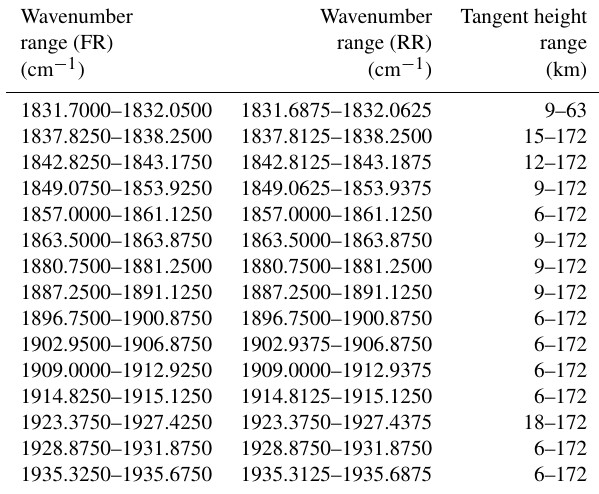
Table 2. Microwindows used in 5.3µm retrievals from FR (first col- umn) and RR (second column)